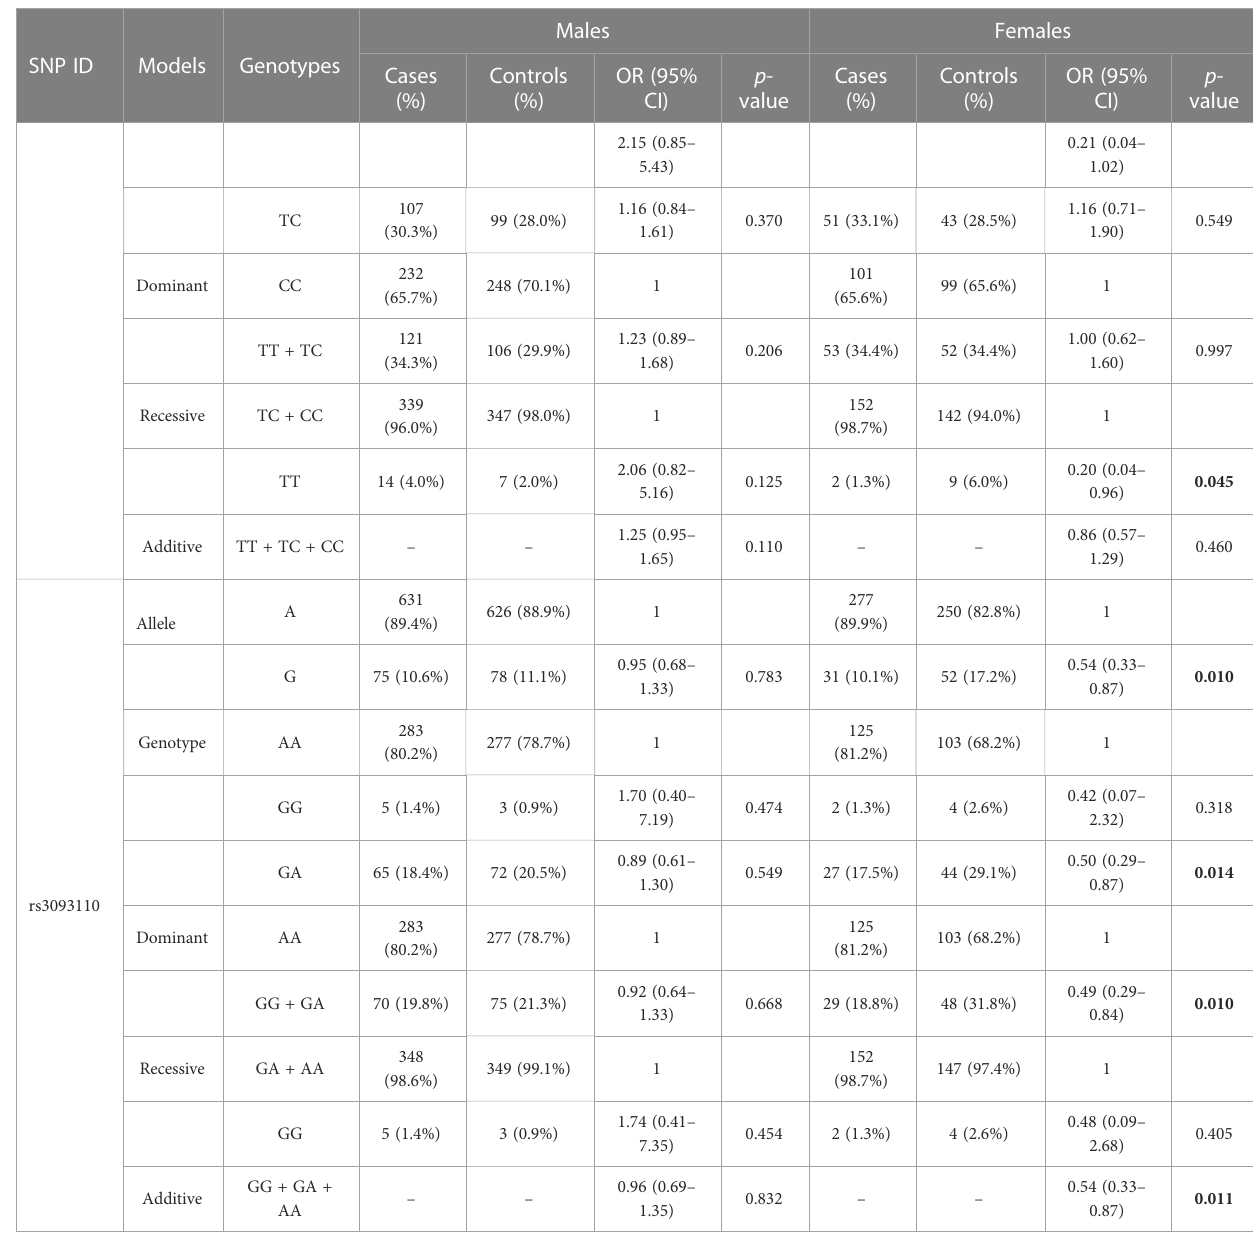
Bold values are statistically signi fi cant; p-values were computed by logistic regression analysis with adjustment for age. SNP, single-nucleotide polymorphism; BMI, body mass index; OR, odds ratio; 95% CI, 95% con fi dence